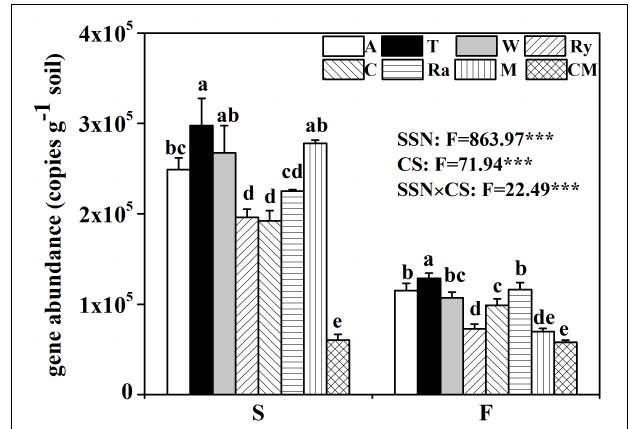
FIGURE 2 | Abundance of the nifH gene among eight cropping systems in the spring (S) and fall (F) cropping seasons. Data with different letters in each column indicate significant differences among the samples ( p < 0.05, one-way ANOVA). F- value from two way ANOVA analysis of effects of season and cropping system on nifH gene abundance. SSN, season; CS, cropping